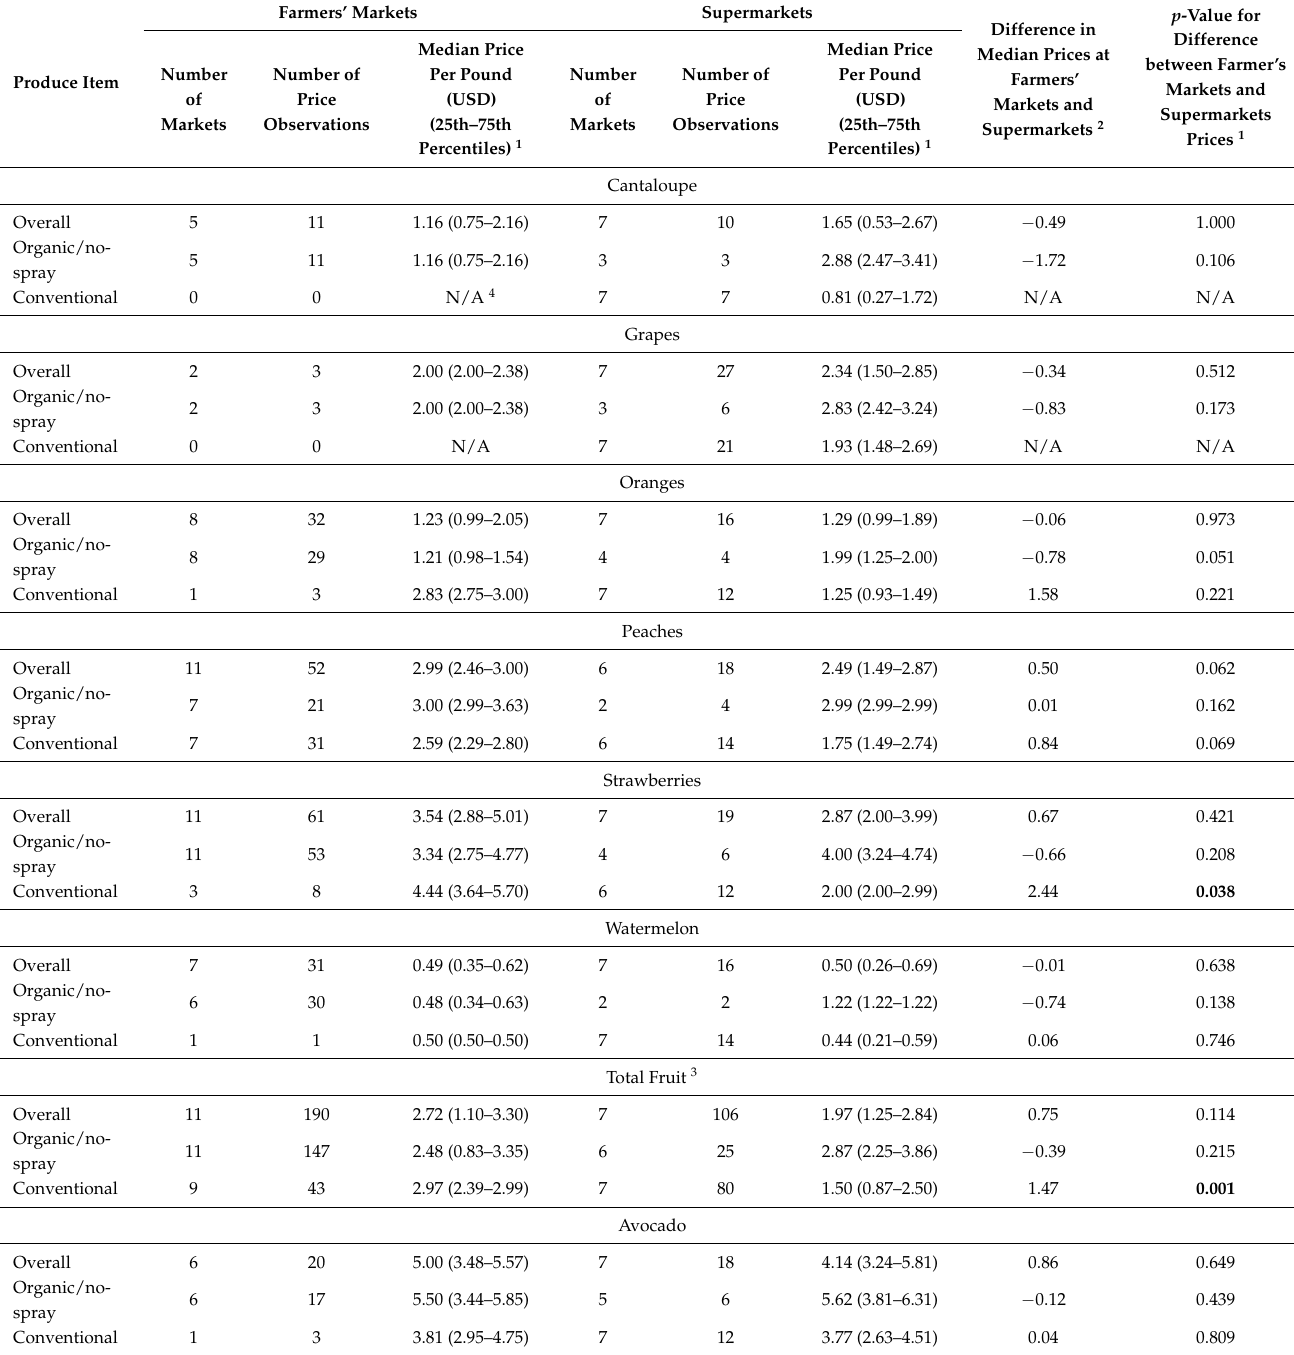
Table 1. Produce price differences in farmers’ markets and supermarkets in California, CNIP evalua- tion, summer